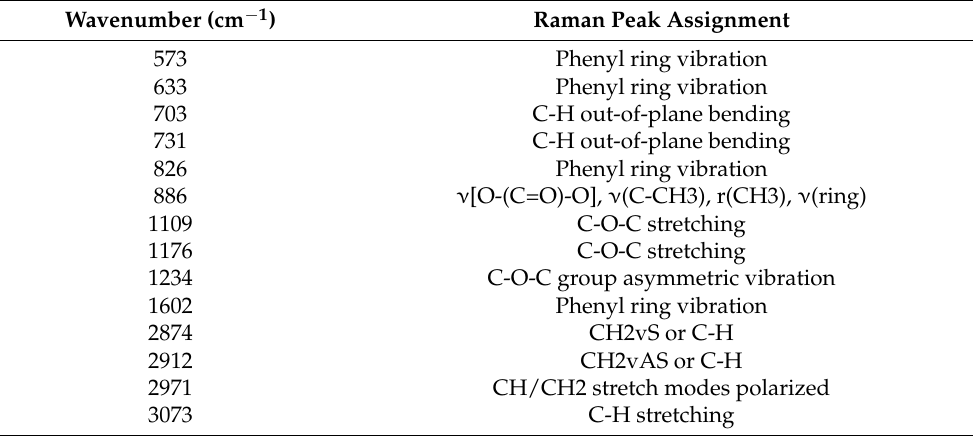
Table 3. Major Raman peaks identified and their related